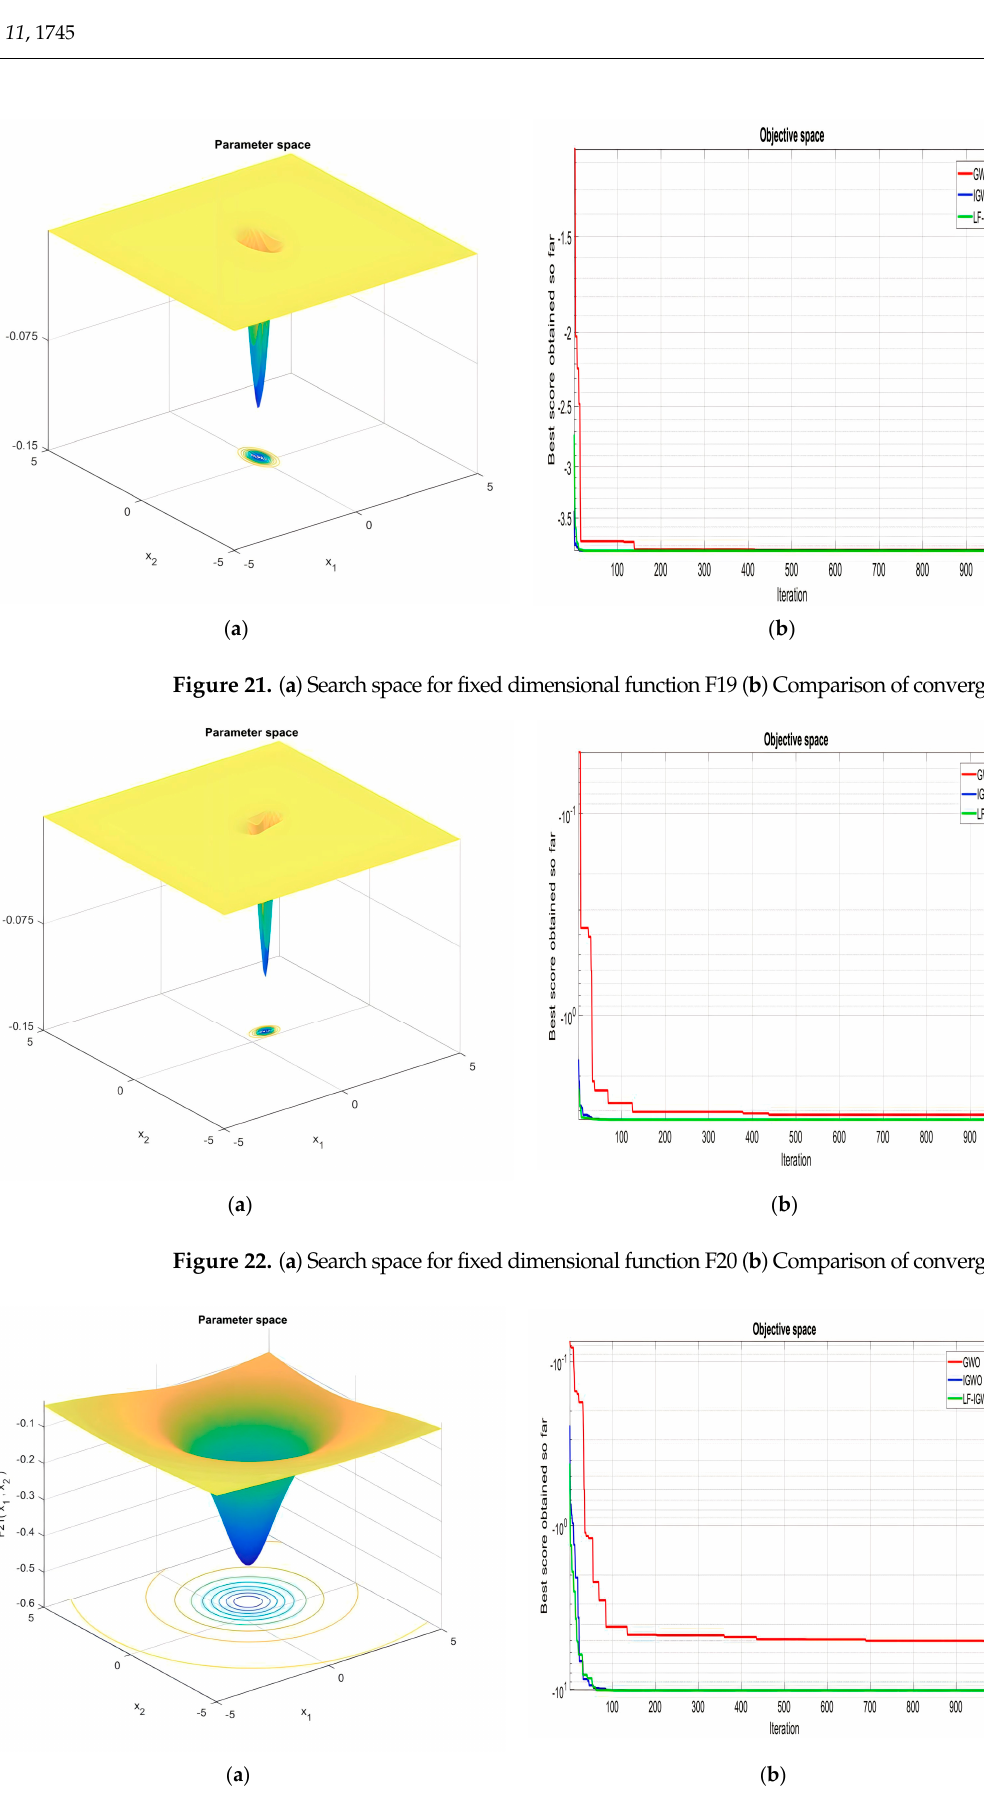
Figure 23. ( a ) Search space for fi xed dimensional function F21 ( b ) Comparison of convergence curve for F21.